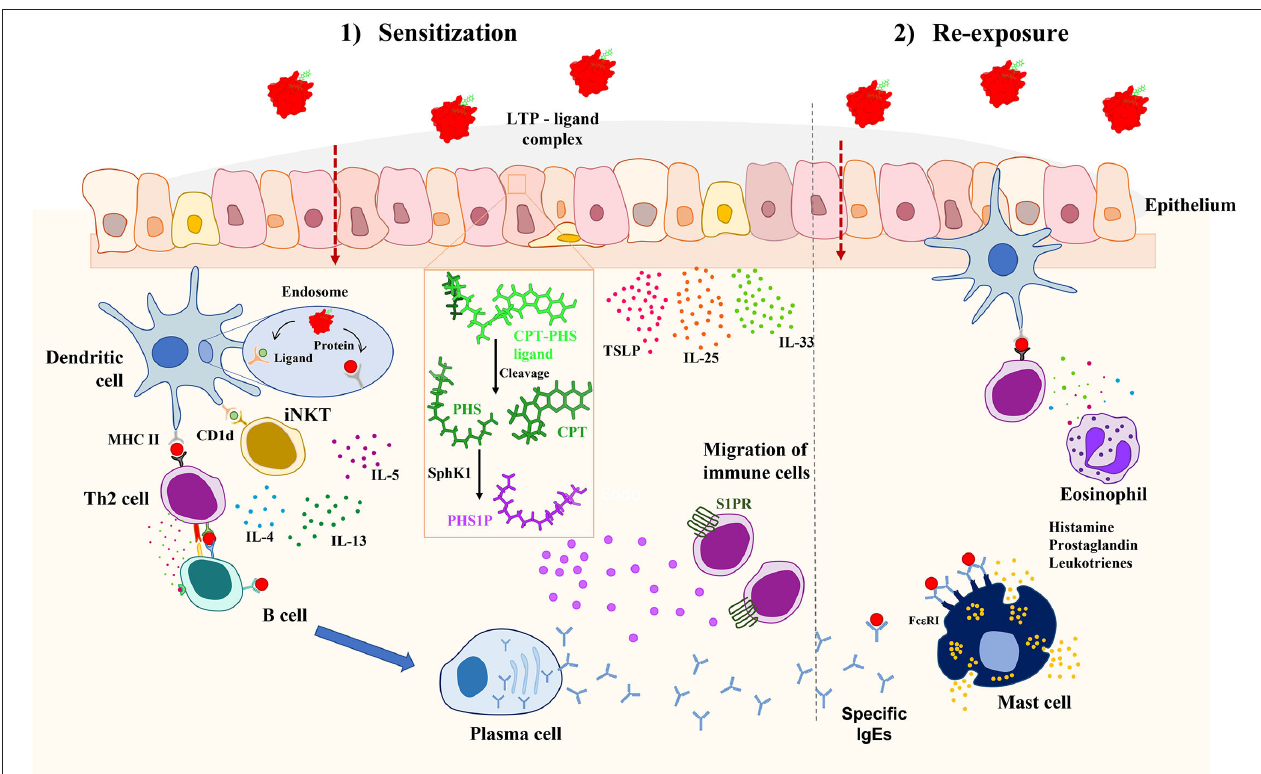
FIGURE 1 | Proposed mechanism of allergic sensitization mediated by LTPs and its associated CPT-PHS ligand in vivo . When the complex crosses the epithelium, the CPT-PHS ligand can be both presented by CD1d in dendritic cells to iNKTs, leading to the production of inflammatory cytokines; or converted in phytosphingosine-1-phosphate (PSH1P) inside the epithelial cells, which then promotes the migration of immune cells to the tissue. This explains the adjuvant role of the CPT-PHS ligand, leading to a pro-inflammatory environment in which the protein becomes recognized by the mucosal immune system, promoting the systemic sensitization against it through the production of IgE. CPT, camptothecin; IL, interleukin; iNKT, invariant natural killer T; LTP, lipid transfer protein; MHCII, major histocompatibility complex II; PHS, phytosphingosine; PHS1P, phytosphingosine-1-phosphate; SphK1, sphingosine kinase 1; S1PR, sphingosine-1-phosphate receptor; TSLP, thymic stromal